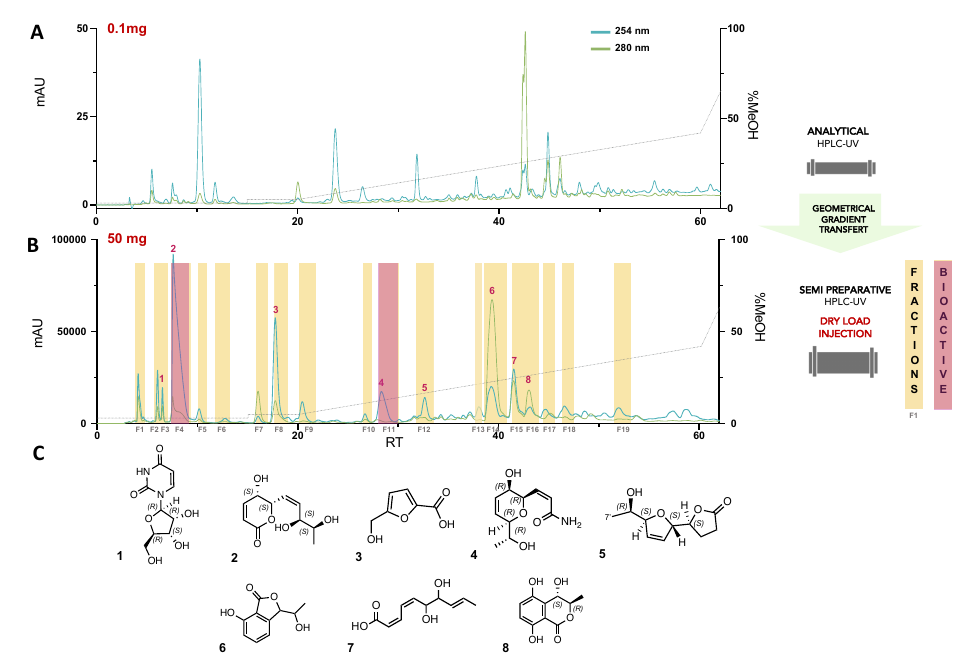
Figure 1. ( A ) Analytical HPLC-PDA profile of the water partition of L. venezuelensis extract (A02W). ( B ) Semi-preparative HPLC-UV profile of A02W with fractions collected by semi-preparative fractionation highlighted in yellow. The active fractions are displayed in pink. ( C ) Pure compounds isolated in a single step (UV peak-based fractionation) and identified via HRMS and NMR analyses.